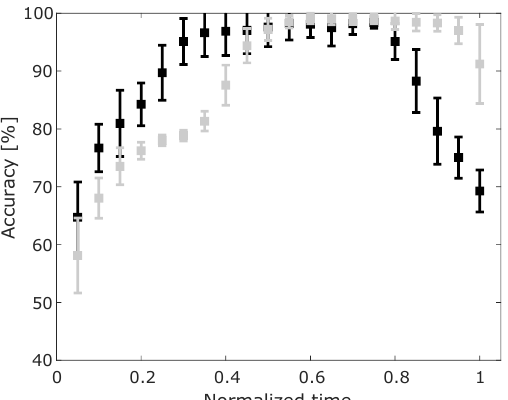
Figure 5. Mean and standard deviation of accuracy over the course of the performed movement for ON/OFF classification. Using only the maximum GMM probability (black) and using GMM+S (grey).